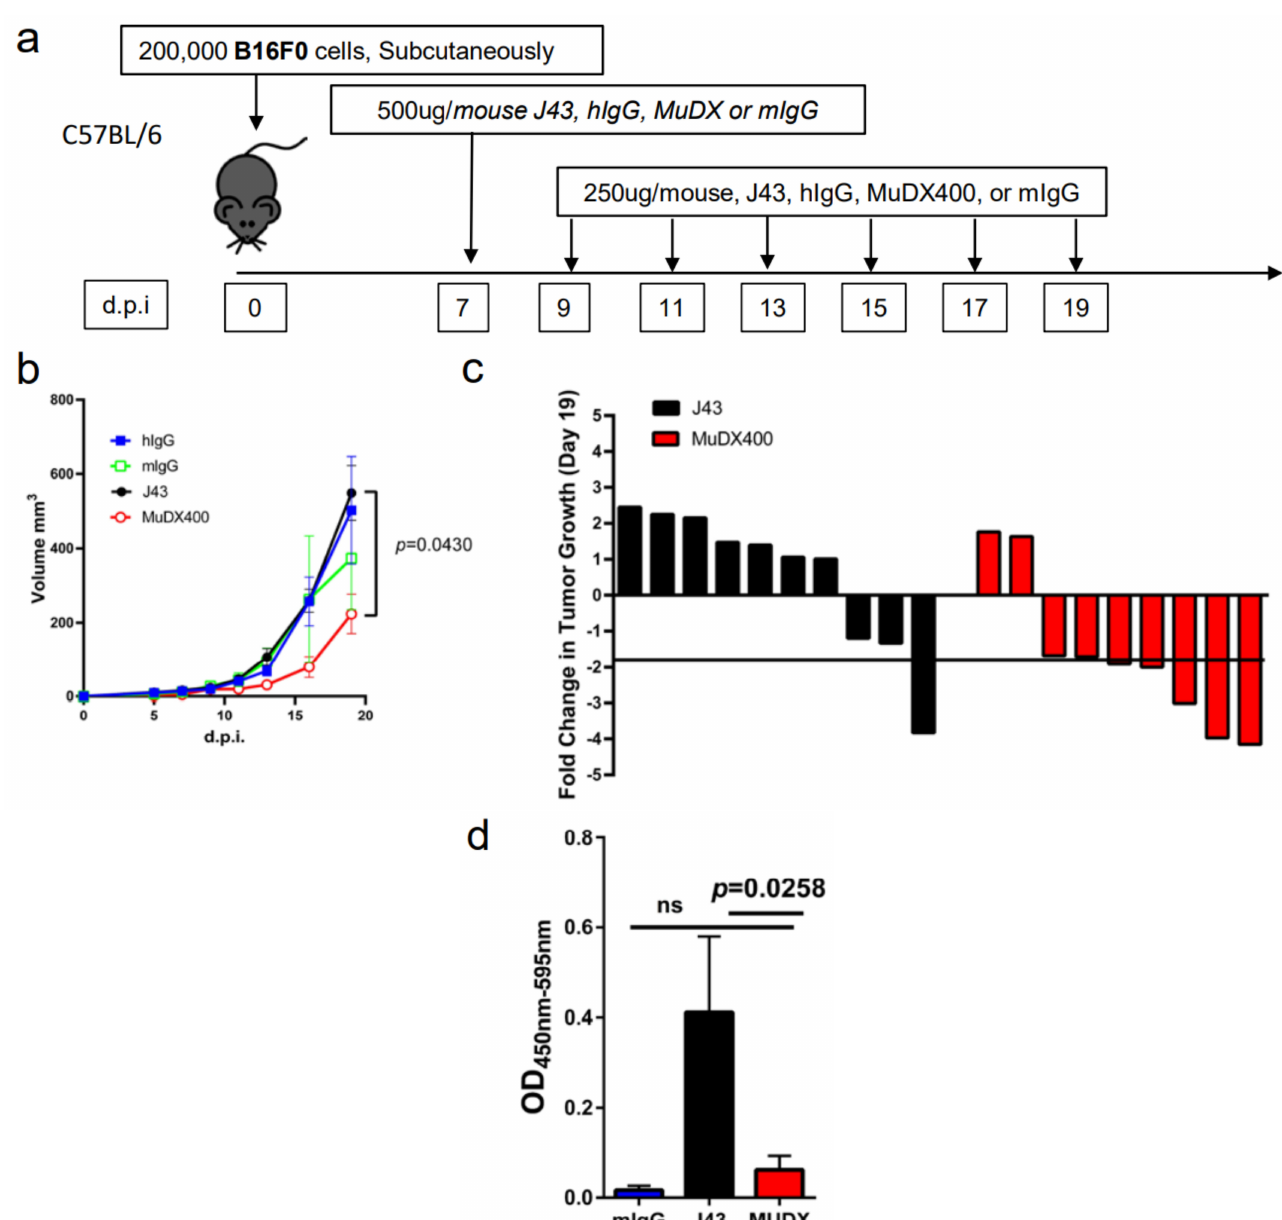
Figure 3. Repeated murine α PD-1 treatment displayed antitumor efficacy in the B16 melanoma model. ( a ) Experimental schema: C57BL/6 mice were inoculated with B16-F0 melanoma cells subcutaneously and administered with either J43 or MuDX400. ( b ) Tumor growth curves of B16-F0 in C57BL/6 mice. Tumor volumes depicted as mean ± s.e.m. ( c ) Waterfall plot of pooled data demonstrating fold change in tumor growth compared to IgG treated controls. ( d ) ELISA assessment of J43 reactive IgG antibodies in the serum of B16-F0 tumor bearing mice with or without treatment. Bar graphs represent the mean value and error bars represent the standard error of the mean. n = 9 to 11 mice per